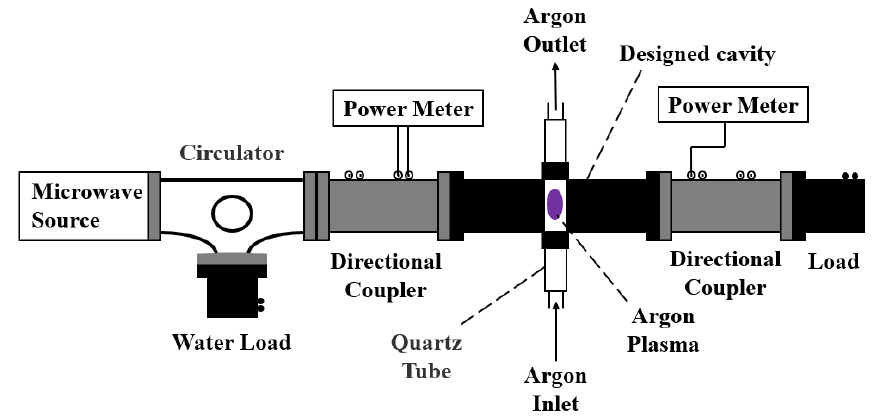
Figure 1. The schematic diagram of the device.